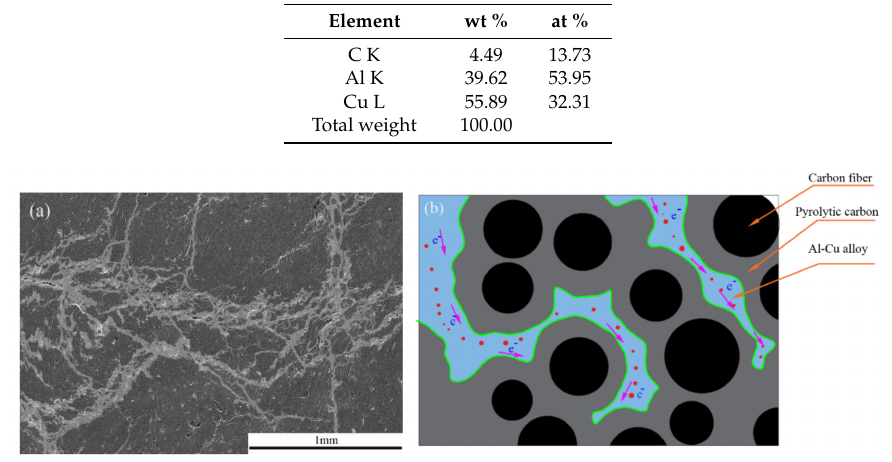
Table 3. Quantitative analysis of the alloy energy spectrum. Element